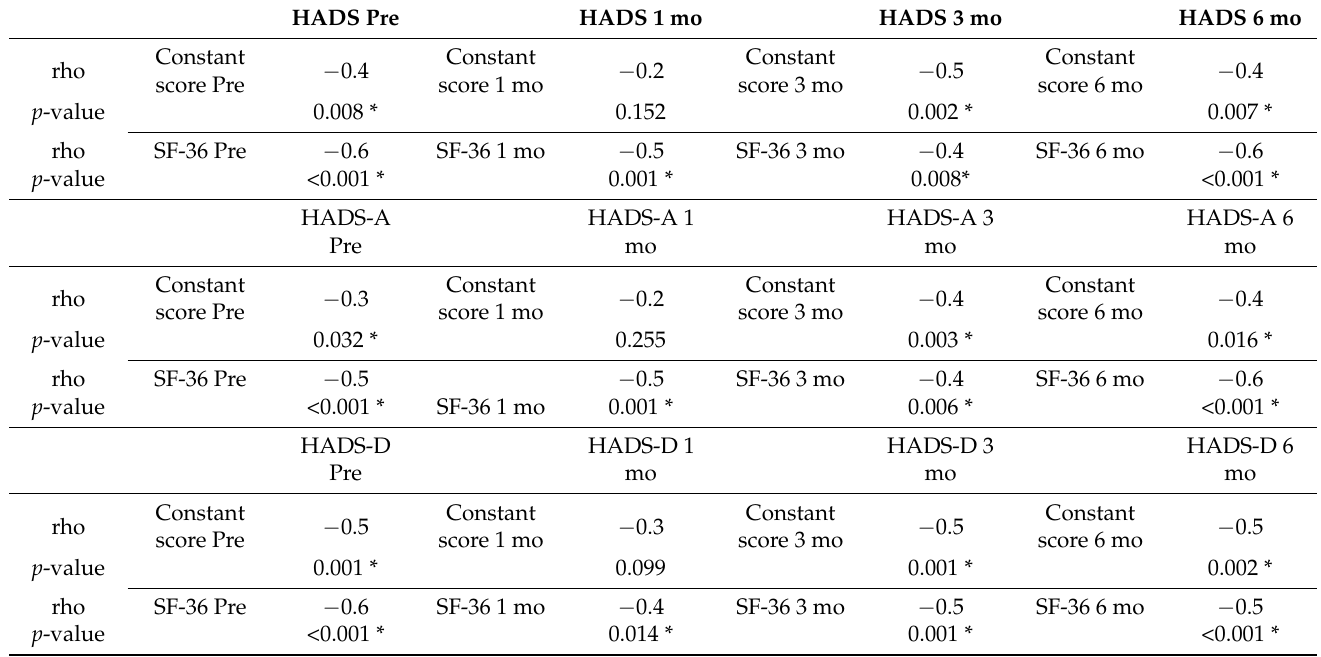
Table 3. Statistically significant correlations between HADS, HADS-A, HADS-D, CMS and SF-36. Each comparison is made between the score at the same